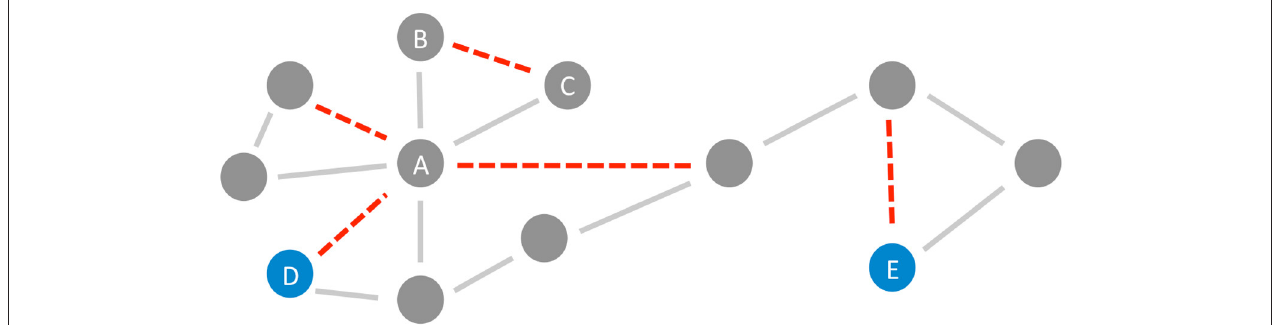
FIGURE 6 | Neurodegeneration in Alzheimer’s Disease (AD) from a network perspective. In this schematic example network, the red links (edges) are being weakened and progressively disconnected by AD. Preferentially, edges attached to nodes with high degree (hubs) are being targeted (here node A) (Stam et al., 2009; Lo et al., 2010; Yan et al., 2018). Besides, lower clustering in AD has repeatedly been observed (Brier et al., 2014b; Minati et al., 2014; Pereira et al., 2016; Dai et al., 2019), i.e., links involved in triangles are broken off (here, e.g., the link between nodes B and C forming the triangle A-B-C). These two “attacks” of AD on the network lead not only to a lower clustering coefficient but also evoke a lower efficiency, defined here as the inverse of the global path length. This lower efficiency is demonstrated in the example network by the shortest path length between the blue nodes D and E before and after the deletion of the red links (before: 4 links, after: 6